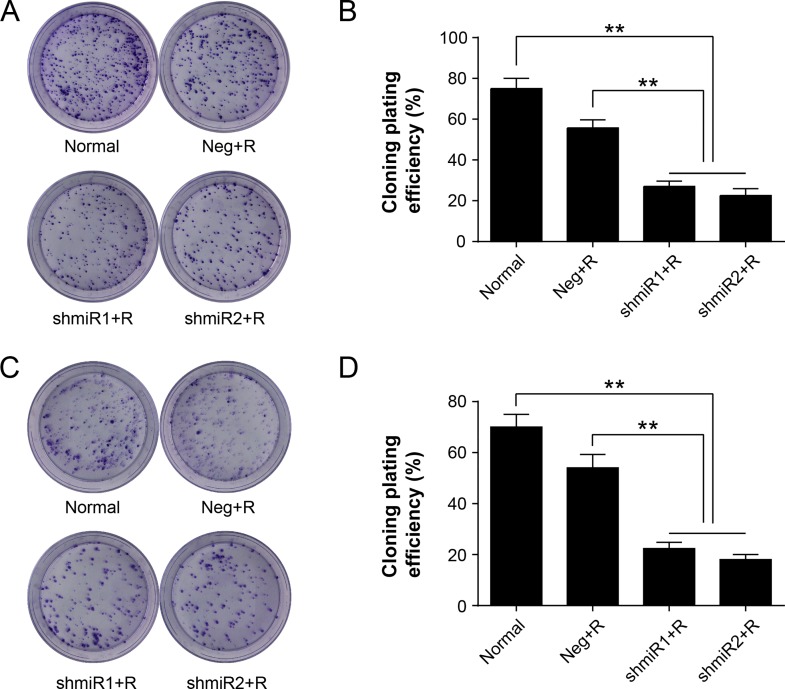
Radiation induced knockdown of LGMN impairs colony formation.(A) Representative images of clone-forming assay of SK-BR-3 cells receiving different treatments. (B) Comparison of cloning efficiency of SK-BR-3 cells. (C) Representative images of clone-forming assay of MDA-MB-231 cells receiving different treatments. (D) Comparisons of cloning efficiency of MDA-MB-231 cells. ** P<0.01. Data was shown as the means ± SD from three independent experiments. The group definition is the same as Fig 1.